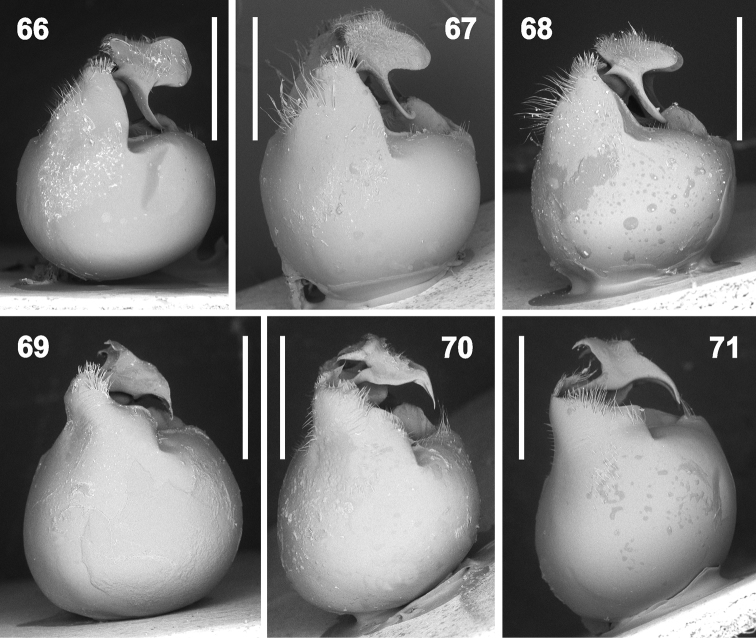
Genital capsule and hypandrium in lateral view (magnification 35×). 66Rh.grandicallosagrandicallosa Bergroth, 1911, French Guiana, Camp Caimans 67–68Rh.grandicallosacentroamericana subsp. n.: 67 Panama, Pipeline Road 68 Costa Rica, Rancho Quemado 69Rh.henryi sp. n., holotype, French Guiana, Camp Caimans 70Rh.meinanderi Becker & Grazia-Vieira, 1971, Ecuador, Yasui NP 71Rh.wheeleri sp. n., holotype, Guyana. Scale bars: 1 mm. (micrographs P. Kment)